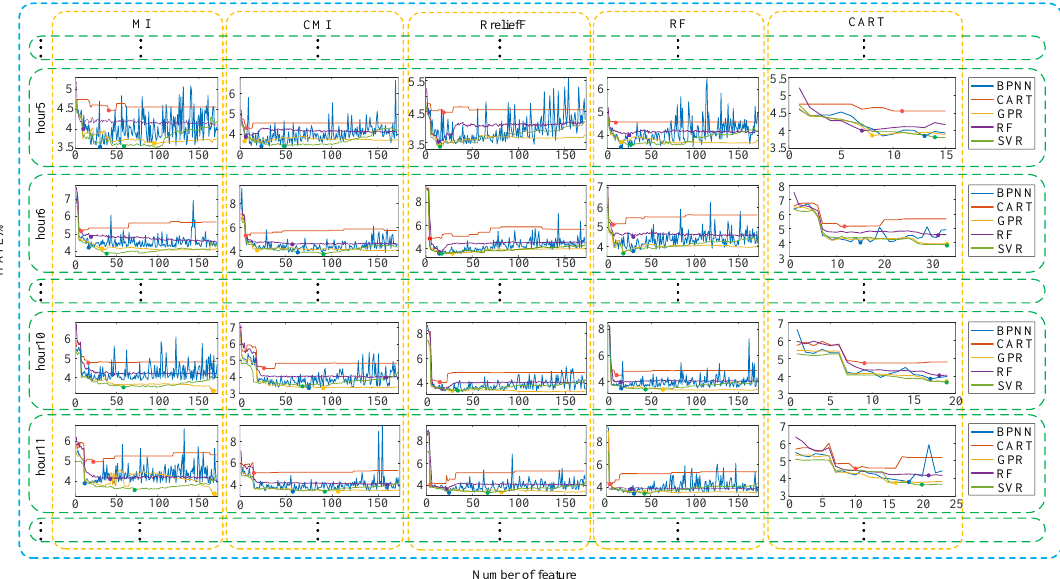
Figure 4. Mean absolute percentage error (MAPE) curves of combinations of feature selection methods and forecasting methods for selecting feature subset.